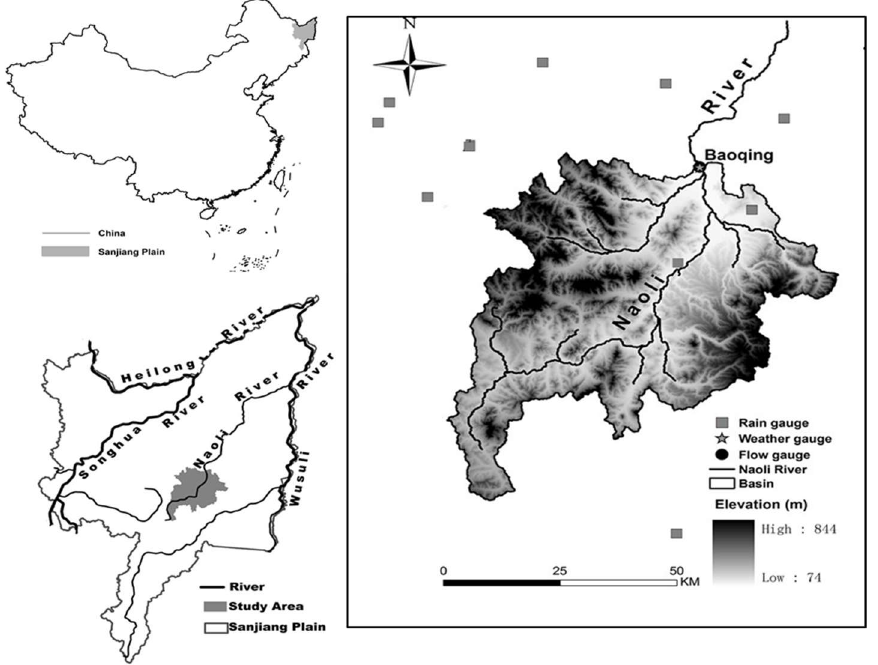
Figure 1. Location of the upper Naoli River catchment.